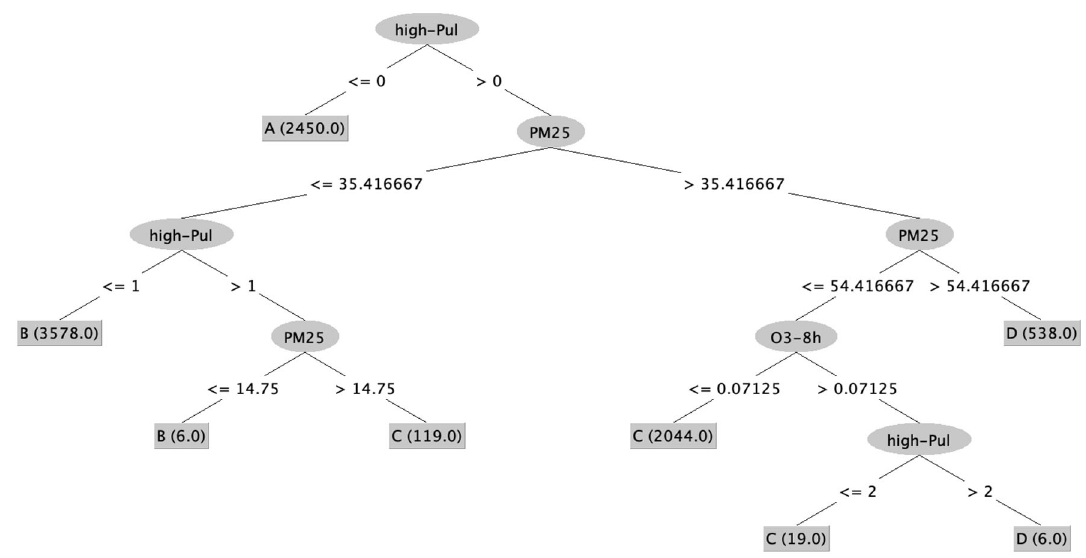
Figure 2. Tree of Fengshan dataset (selected variables) by DT.